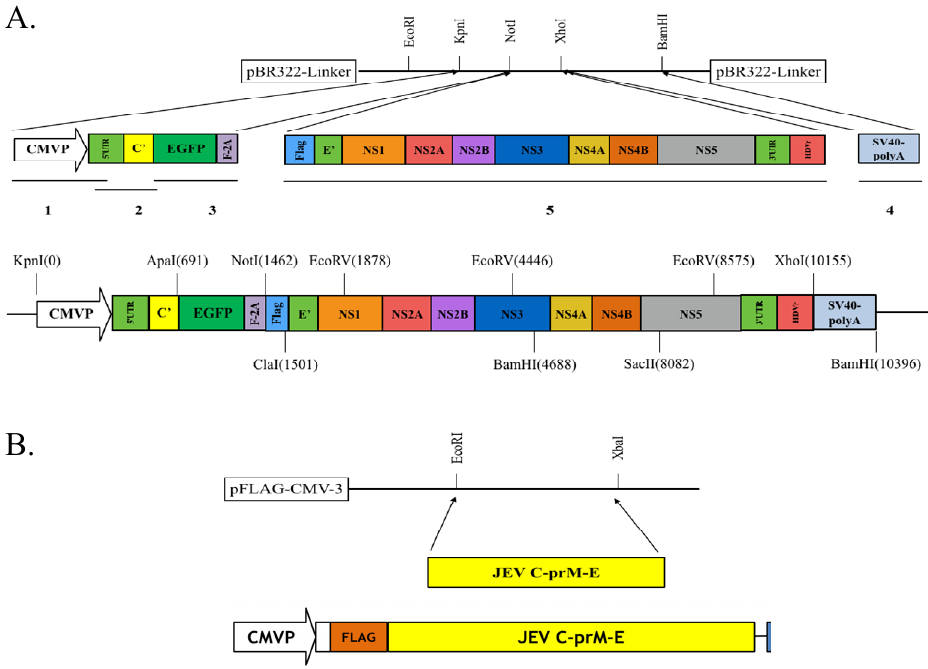
Figure 2. Construction of pBR322-based JEV replicon and pFlag-CMV3-CprME. ( A ) The DNA fragments of CMV promoter, JEV genome cDNA, EGFP and SV40-polyA were amplified using PCR, and then assembled into the indicated restriction sites of the pBR322 plasmid; ( B ) The cDNA sequence encoding structural proteins was amplified using PCR and cloned into the pFlag-CMV3 with EcoRI and XbaI double digestion. The detailed procedure was described in the section of Materials and Methods.